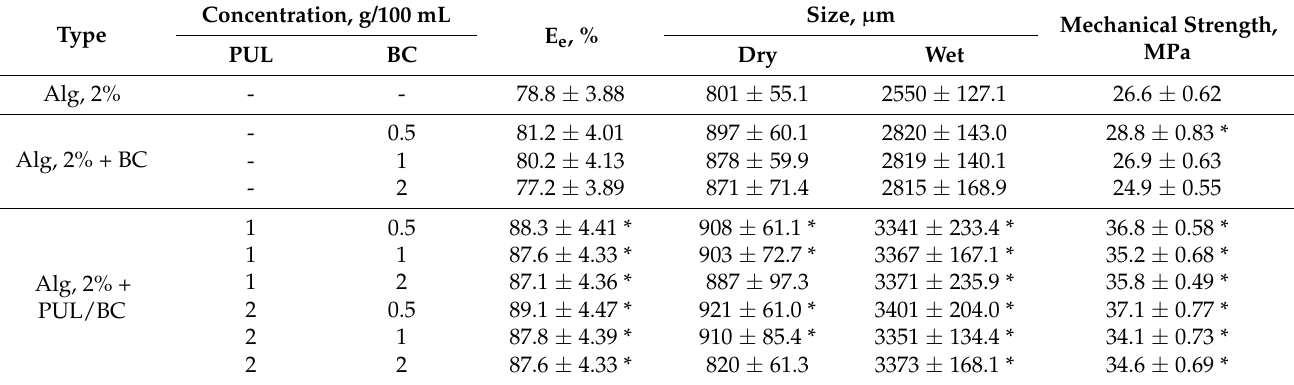
Figure 1. The scheme of beads with L. rhamnosus GG (LGG): ( A ) Alginate/Bacterial cellulose (Alg/BC), ( B ) Alginate-Pullulan/Bacterial cellulose (Alg-PUL/BC). The probiotic was included either in Alg alone or in Alg with PUL. Both versions of the capsules were placed from the gelling agent solution into regenerated cellulose gel to form an outer shell on the surface of the capsules.